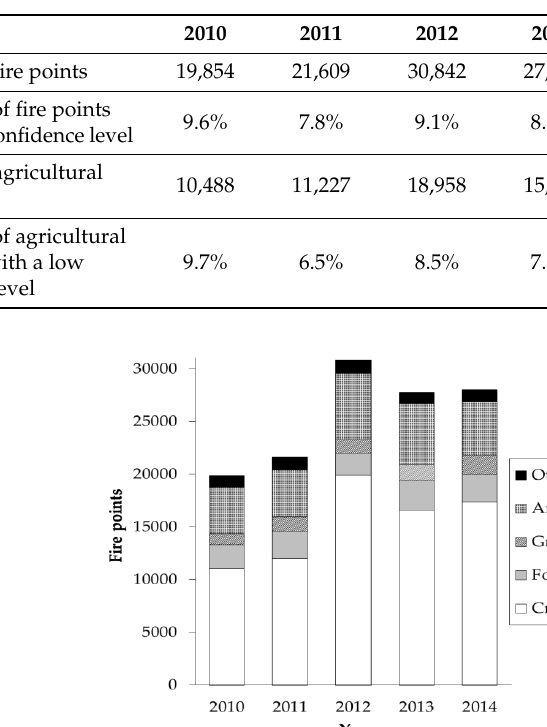
Table 2. The proportion of agricultural fires and fires detected with low confidence levels.